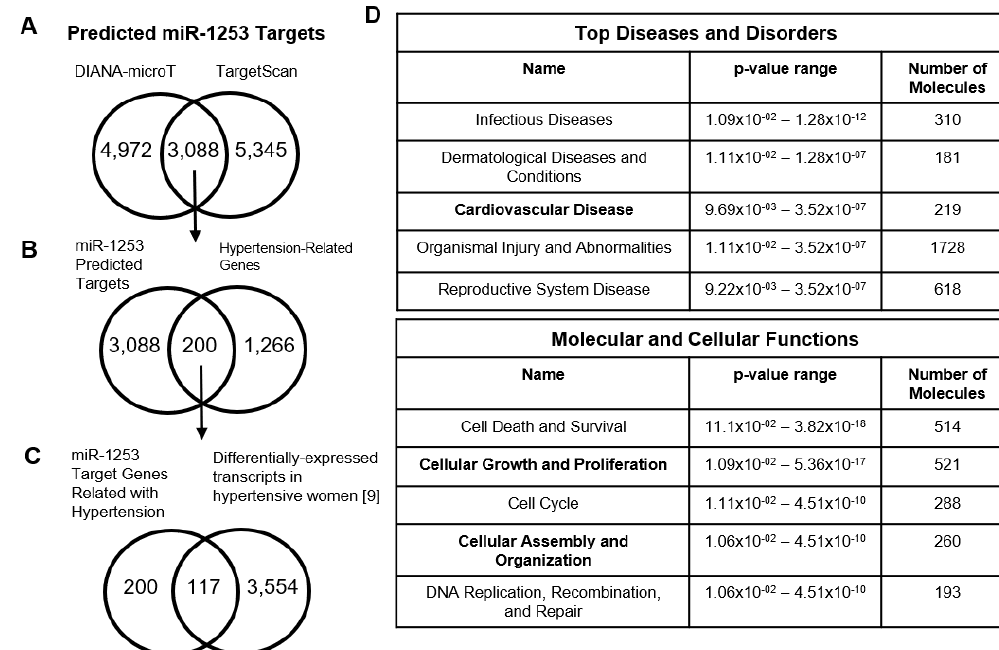
Figure 1. Target prediction analysis for miR-1253. ( A ) Venn diagram of the predicted miR-1253 targets overlapping between the DIANA-microT and TargetScan algorithms. ( B ) Venn diagram of overlapping, predicted miR-1253 targets that are within a previously curated [9] list of hypertension-related genes. ( C ) Venn diagram of the predicted hypertension-related miR-1253 targets that are significantly, differentially expressed in peripheral blood mononuclear cells (PBMCs) in hypertensive women. ( D ) List of significant top diseases and disorders (top) and molecular and cellular functions (bottom) in human aortic endothelial cells (HAECs) transfected with 50 nM miR-1253 mimic. These pathways were identified by Ingenuity Pathway Analysis.